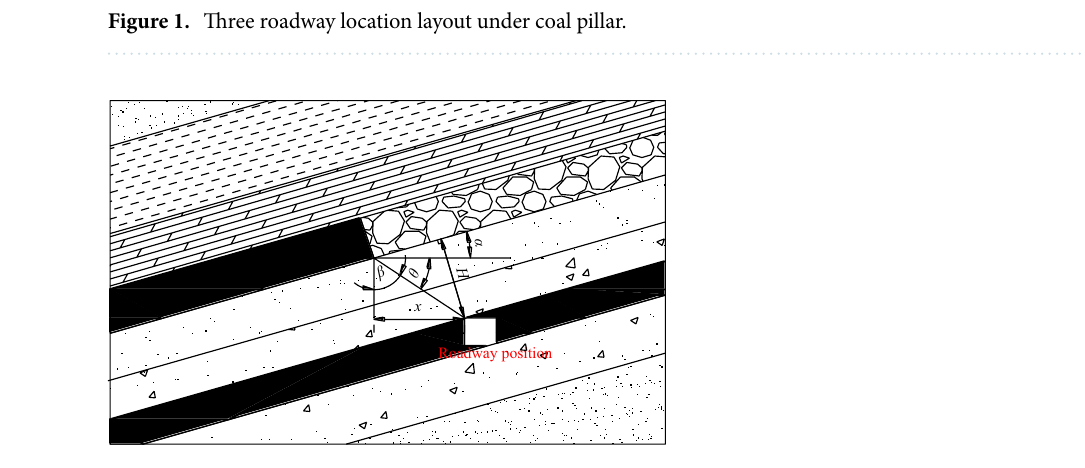
Figure 2. Calculation diagram of roadway location in the floor 10–14